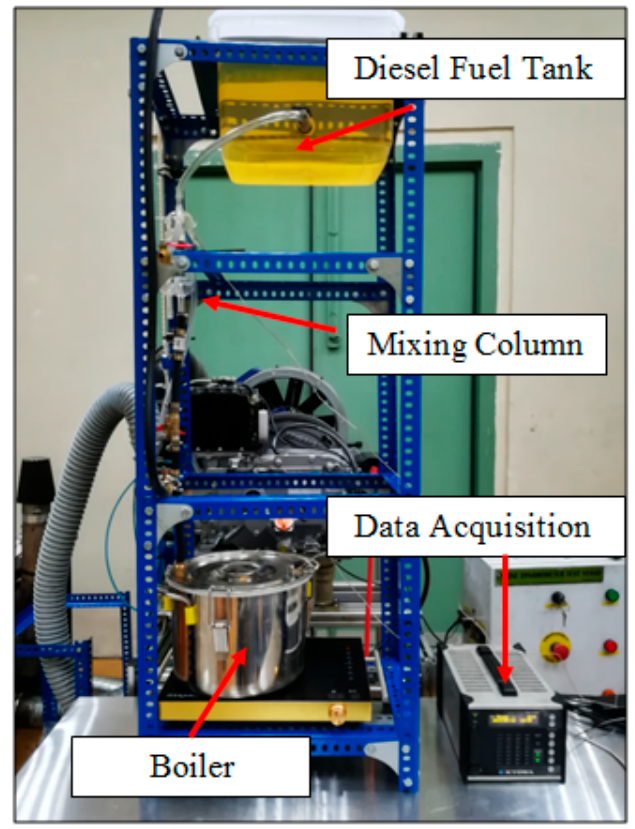
Figure 2. Apparatus setup for steam-generated emulsion fuel.